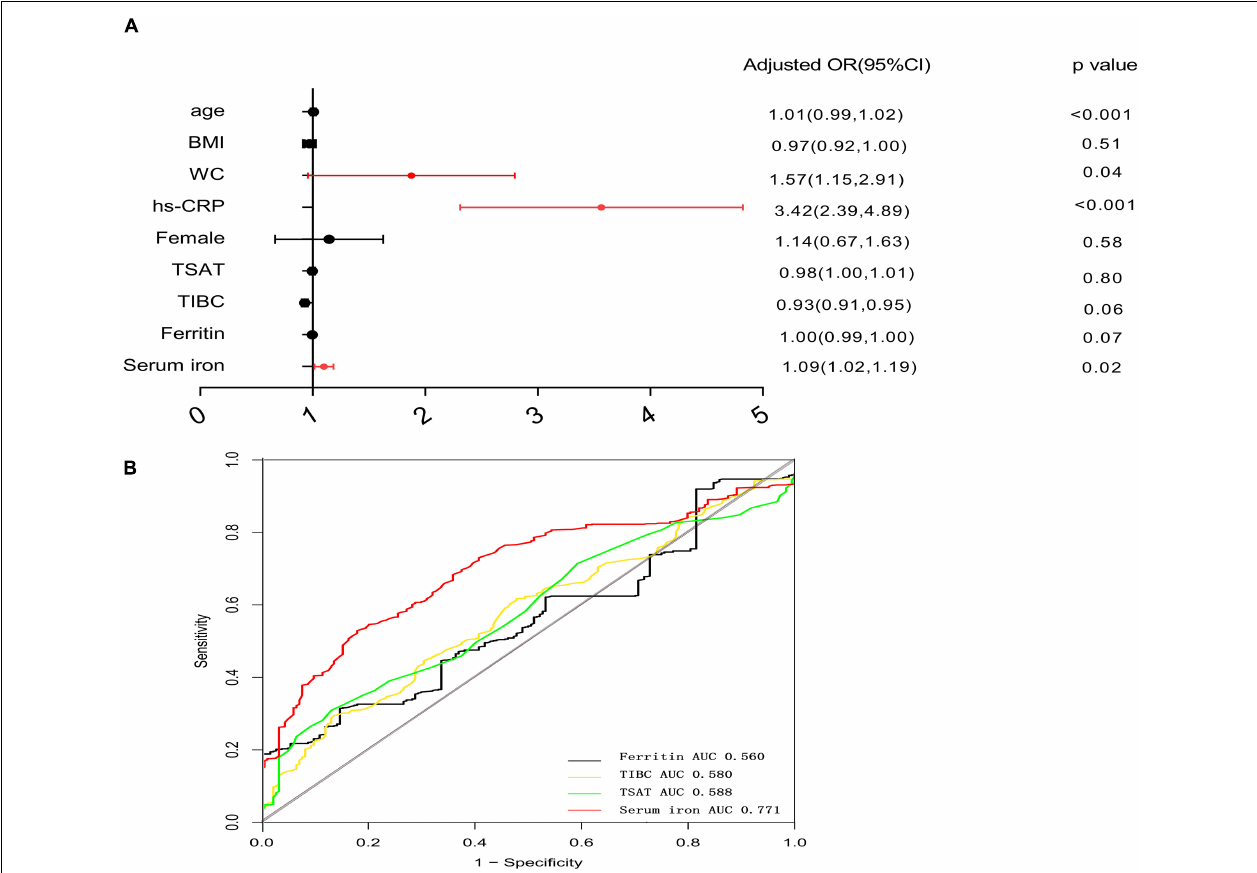
FIGURE 1 | Forest plots for multivariate logistic analysis of variables for high A/G ratio and receiver-operating characteristic curve analysis of iron metabolism biomarkers for high A/G ratio. (A) Multivariate analysis: adjusted OR after adjustment for age, gender, BMI, WC, and high-sensitivity C-reactive protein (hs-CRP). (B) ROC analysis of iron metabolism biomarkers for a high A/G ratio. The cutoff value of serum iron for high A/G ratio was defined as the optimal sensitivity and specificity of the ROC curve. OR, odds ratio; ROC, receiver operating characteristic analysis; and A/G ratio, android-to-gynoid fat